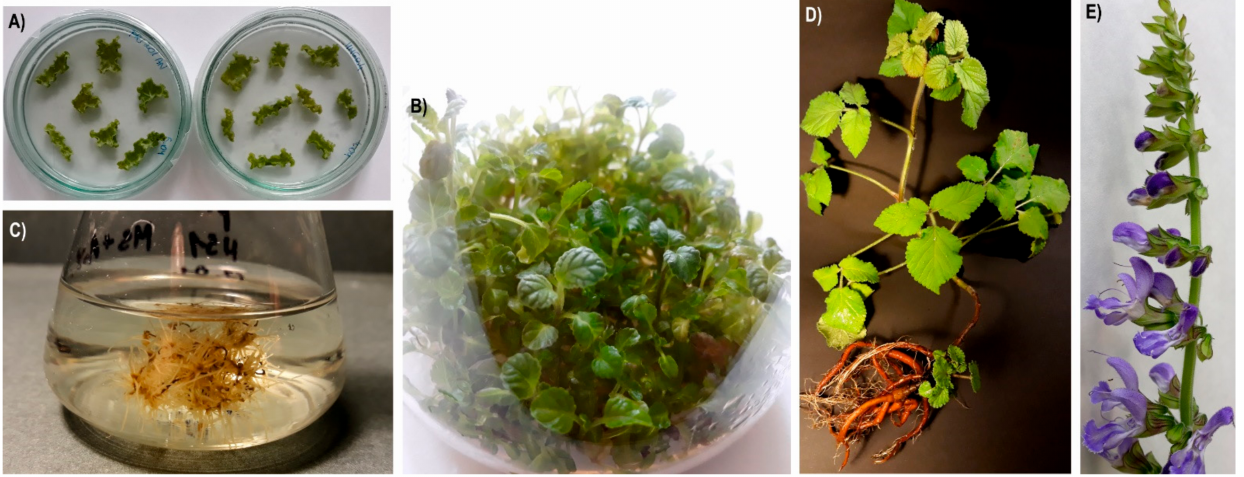
Figure 4. Cultures of S. miltiorrhiza at various stages of transformation, regeneration and growth. ( A ) callus resistant to selection antibiotics after two weeks of growth, ( B ) shoots regenerated from callus three months after the experiment began, ( C ) culture of roots transformed with the pRI201-AN- HMGR4 construct, ( D ) plant transformed with the pRI201-AN-HMGR4 construct after several months of growing in soil, ( E ) flowering of the plant transformed with the pRI201-AN-HMGR4 construct. The transformation of S. miltiorrhiza plants was confirmed by PCR analysis of genomic DNA isolated from five-week-old leaves using Isolate II Plant DNA kit (Bioline, Taunton, MA, USA) according to the manufacturer’s instructions, with the use of GoTaq Hot Start Green Master Mix (Promega, Madison, WI, USA) and Kanamycin primers (Table 2). The concentration and purity of the DNA were assessed based on A 260 /A 280 and A 260 /A 230 ratios using a Nanophotometer P300 (Implen, Munich, Germany). PCR reaction parameters were as mentioned above. The obtained products were separated via 2% agarose gel